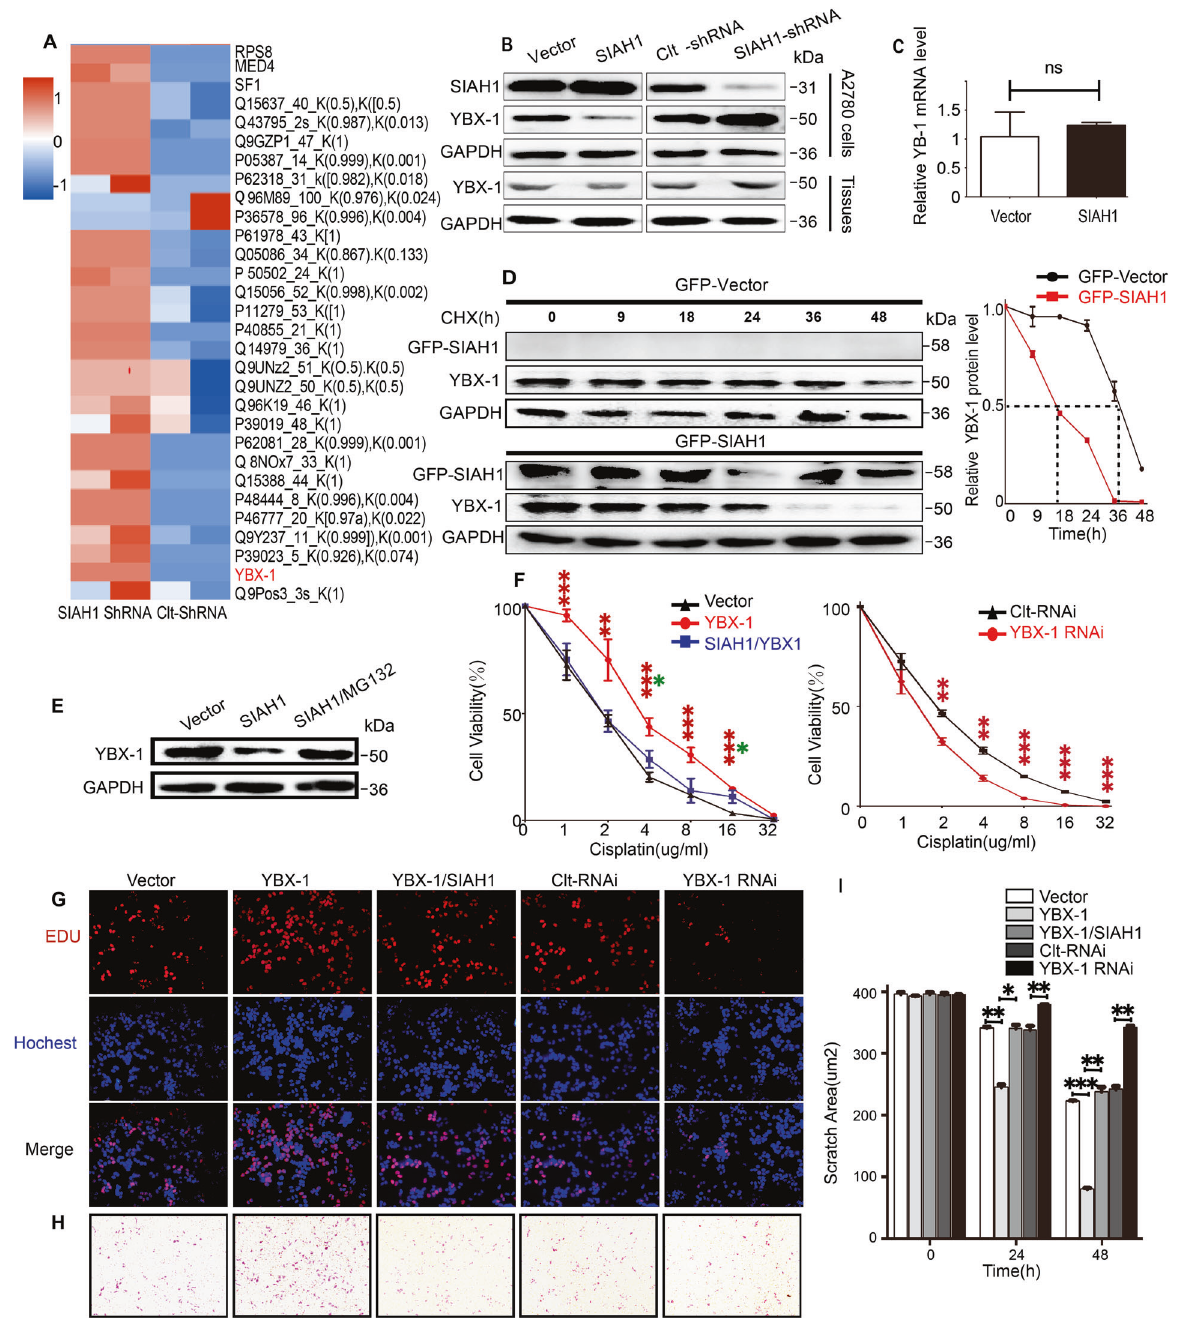
derived from A2780 cells; down, samples were derived from mouse xenograft tumors tissue). C Relative YBX-1 mRNA expression in SIAH1- overexpression cells. D HEK293T cells were transfected with GFP-Vector and GFP-SIAH1 and treated with cycloheximide (CHX) for